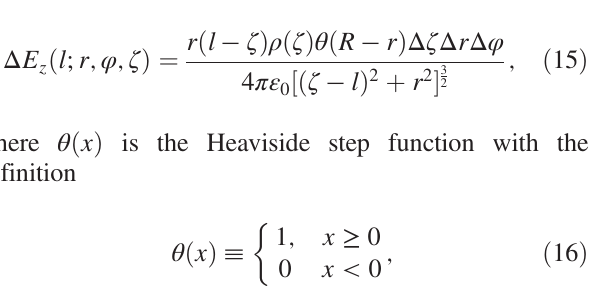
FIG. 5. Illustration of our calculation of the longitudinal space charge field.